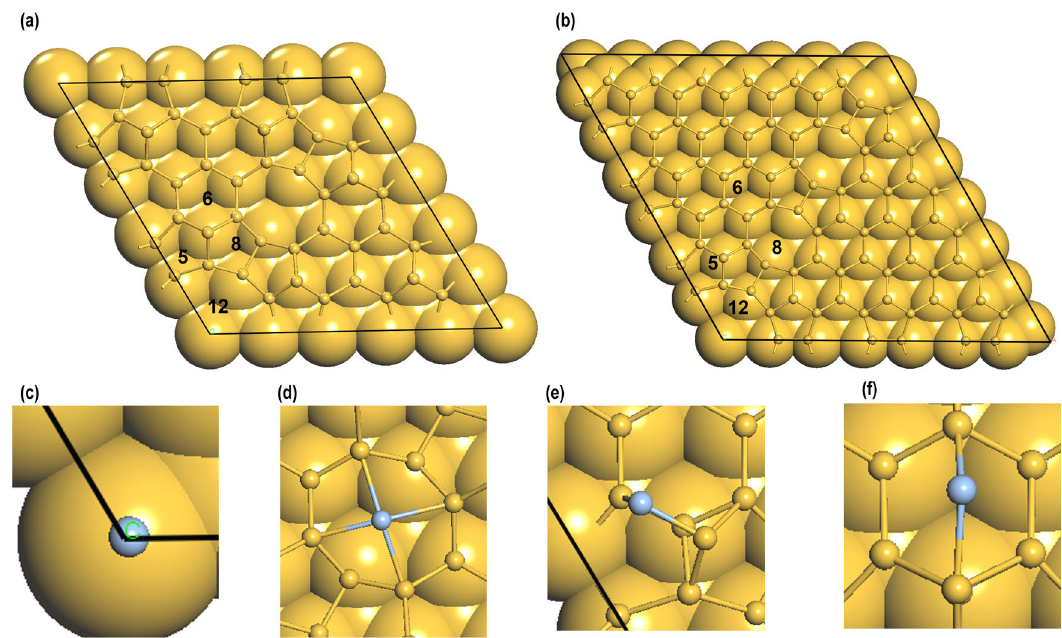
Fig. 4 Adsorption of Ag atom in different sites. ( a ) Si(111)-5×5 and ( b ) Si(111)-7×7 unit cell showing the 12, 8, 6, and 5-membered Si rings on the surface. The optimized structures of Ag adatom (represented by light-blue balls) on ( c ) 12, ( d ) 8, ( e ) 6 and ( f ) 5-membered Si rings on the Si(111)-5×5 surface. For clarity the top two-layers of Si atoms (in yellow) are shown as ball and stick, and the lower layers of atoms are shown in the CPK form.